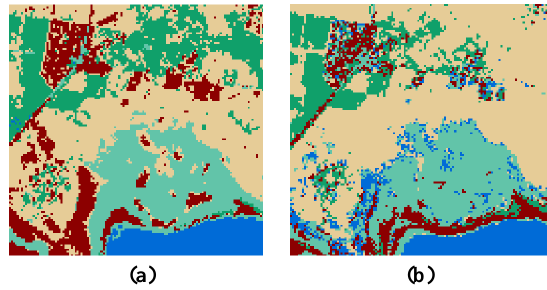
Figure 6. Image clustering. (a) Band classification. (b) Source